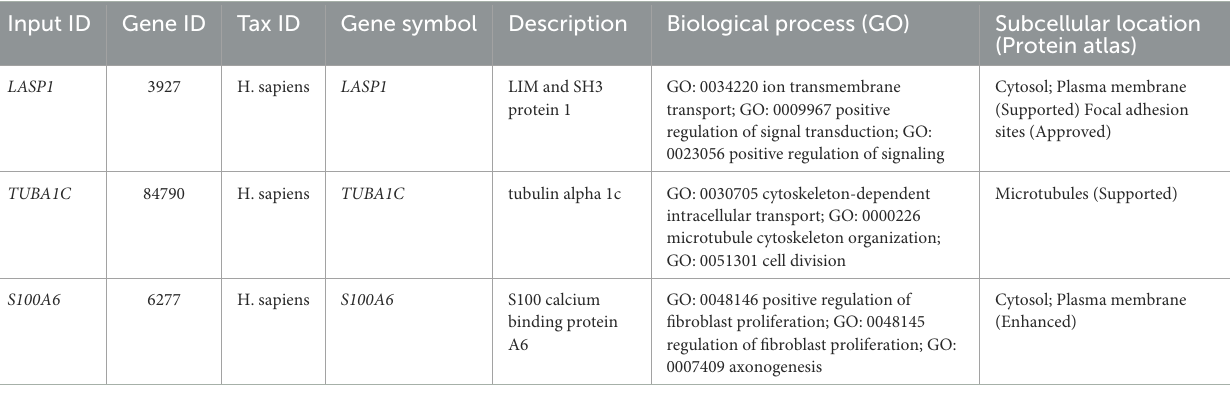
TABLE 6 REST software data compared LASP1, TUBA1c, and S100A6 genes in MS patient and control groups.